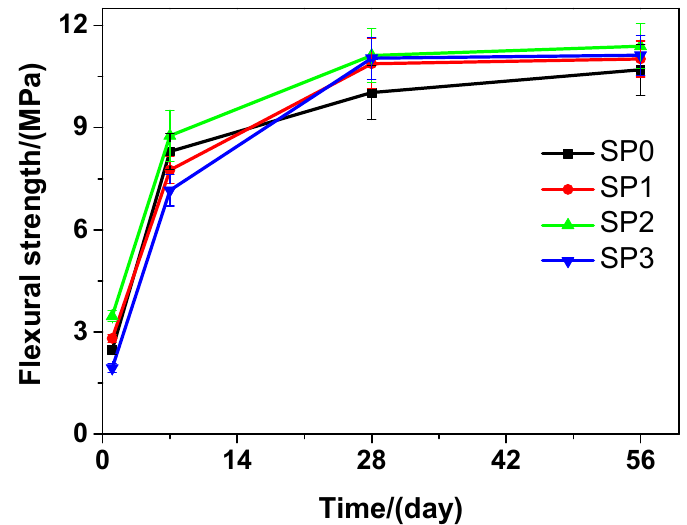
Figure 5. The flexural strength of siliceous sacrificial cement paste at different curing time.